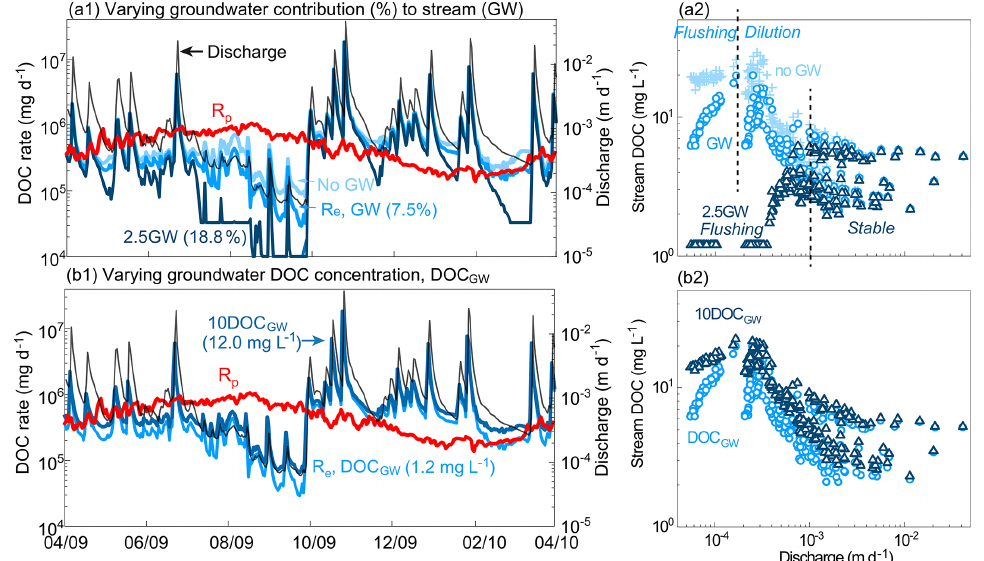
Figure 12. Sensitivity analysis of groundwater on rates ( R p and R e ) and C–Q relationships: (a) scenarios with a different groundwater volume contribution (%) to stream discharge and (b) scenarios with a different groundwater DOC concentration (DOC GW ). DOC GW and GW ( Q G /Q ) in the base case were 1.2mgL − 1 and 7.5%, respectively. “2.5GW” in panel (a) represents the case with 2.5 times Q G compared with the base case. Increases in the relative groundwater contribution lowered R e and shifted the C–Q pattern from an overall dilution pattern to an overall flushing pattern; changing DOC GW had negligible influence on the DOC rates and C–Q